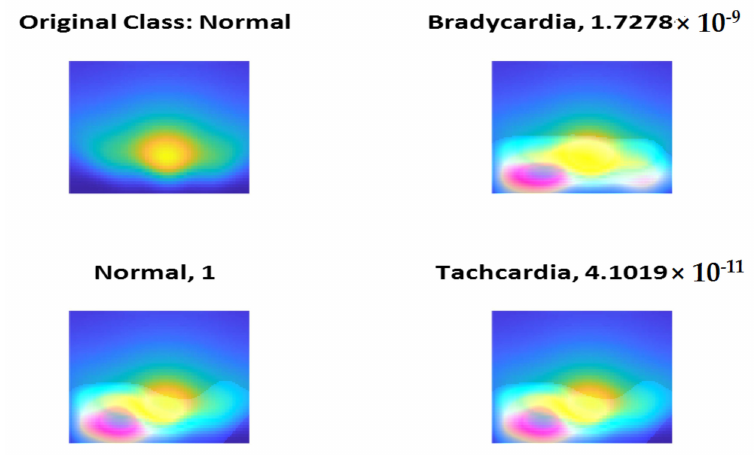
Figure 14. Normal Class CAM using ShuffleNet and Scalogram.